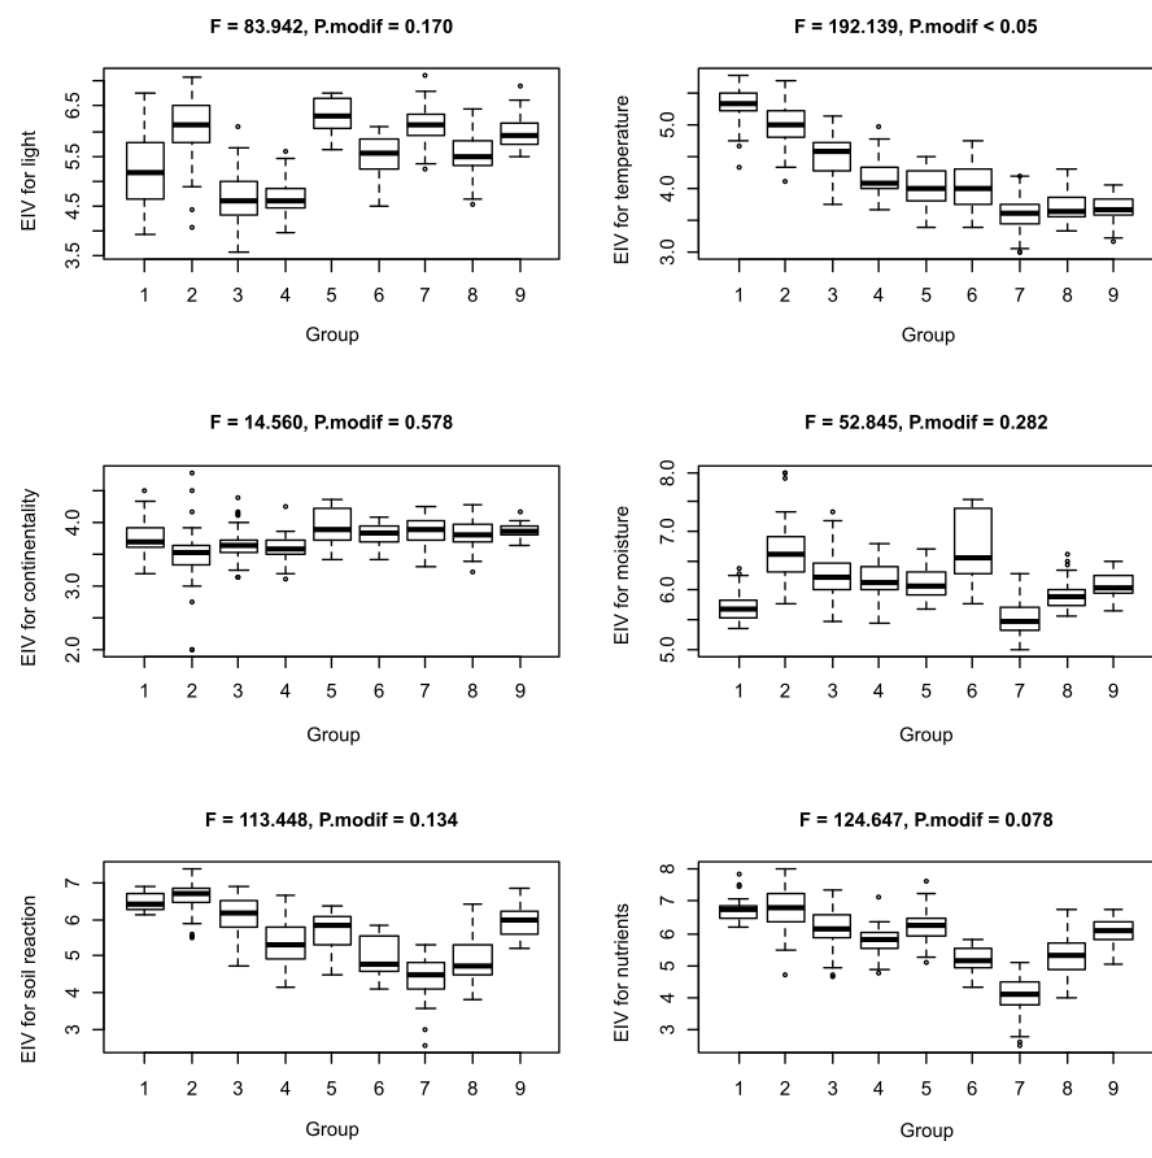
Figure 7. Summary box-and-whisker plots of mean Ellenberg indicator values (EIVs) for clusters recognized within Mulgedio-Aconitetea communities of the Sudetes and their foreland (SW Poland) produced by one-way permutation- al ANOVA. The central line of each box indicates the median value, box boundaries the lower (25%) and upper (75%) quartiles, and whiskers the range of values. p was calculated using a modified permutation test of significance modif for analysis of mean Ellenberg indictor values (EIVs), F-test statistic. Numbers of groups are the same as in Figure